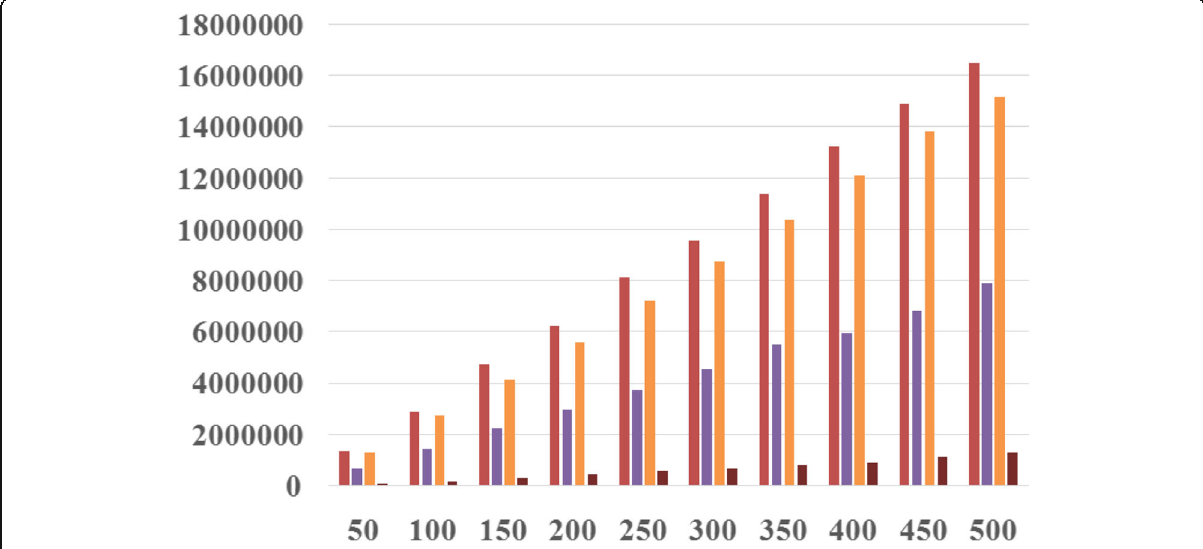
Fig. 10 Total network flow under different task